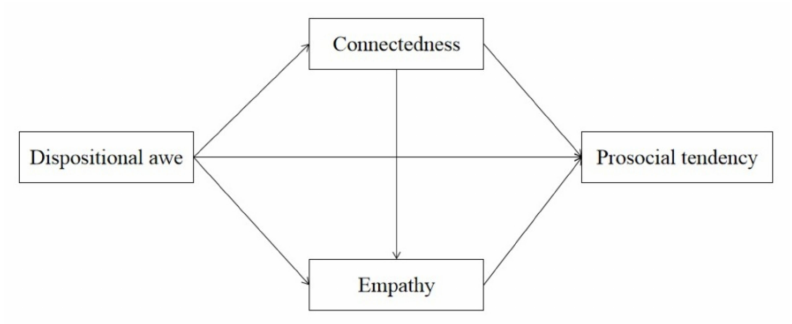
Figure 1. The proposed media